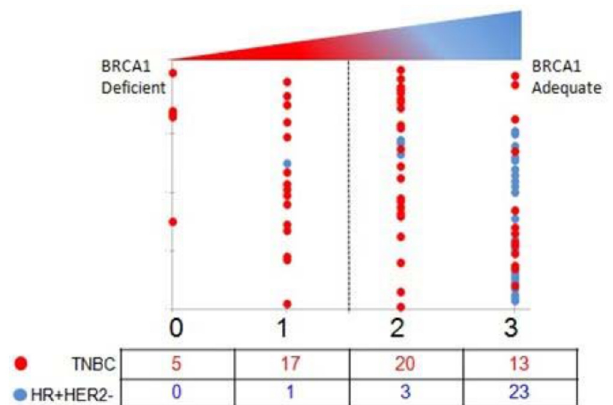
Fig 7. BRCA1 Deficiency Score (BDS). BRCA1 Deficiency Score (BDS): Amalgamated scores range from a low of 0 to a high of 3. Scores of 0 and 1 are almost exclusively seen in TNBCs. Scores of 2 and 3 were seen in both HR+HER2- as well as TNBCs. 23/27 HR+HER2- tumors scored adequate on all measures and hence had a score of 3. This method of selection classified 40% of TNBCs being BRCA1 deficient and only 3% of HR+HER2-ve to be BRCA1